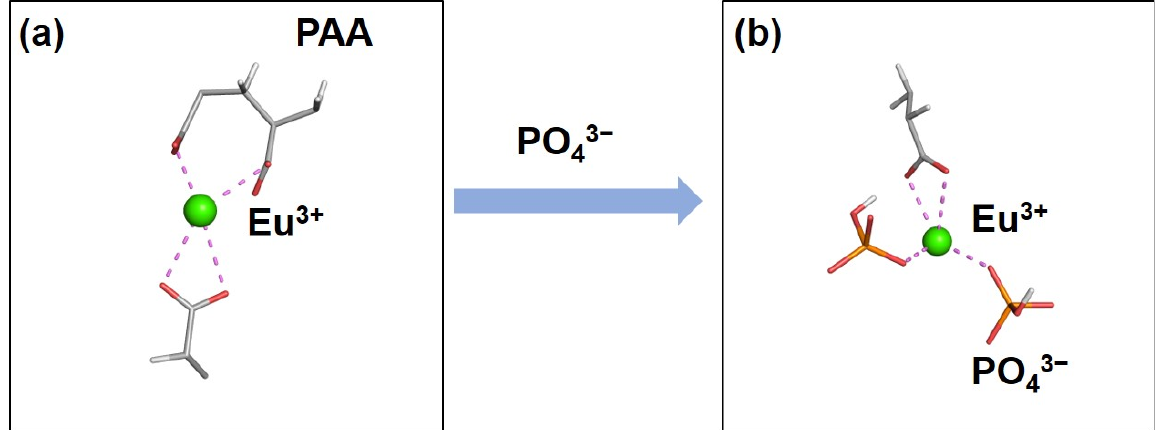
Figure 6. ( a ) The bonding of Eu in PAA-Ca(Eu) nanoclusters; ( b ) The bonding of Eu after adding PO 43 − .